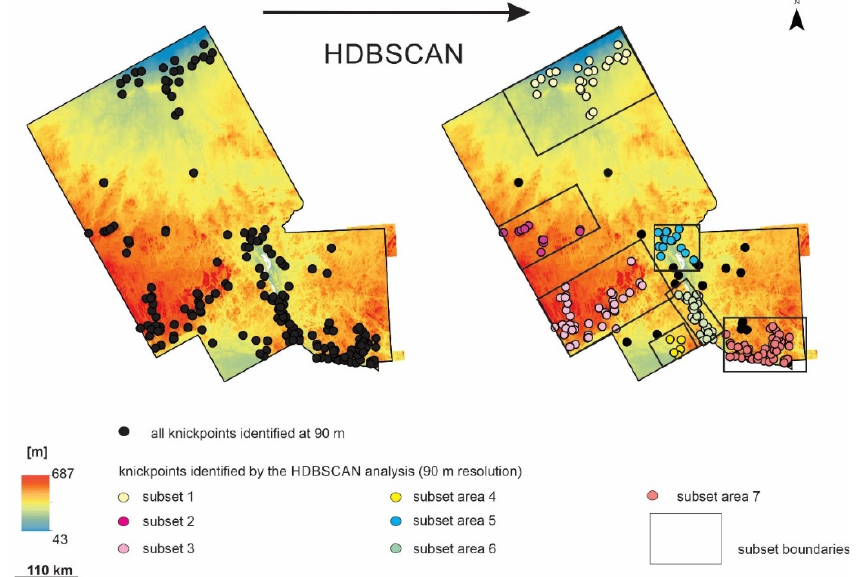
Figure 4. Combined DEM of our study area centered around the Temiskaming Graben with Knickpoints detected at 90 m resolution. The DEM was resampled at 90 m resolution in order to obtain the locations of the knickpoints across the whole study area. This resolution was found efficient for the hydrological calculations run in the MATLAB based software code TopoToolbox [99,100]. HDBSCAN cluster analysis [109] was then run for further detailing our analysis and divide the broad study area into subsets. Seven clusters of knickpoints were thus obtained by the previous passage, and each of these was used to identify a subset of the broad study area (right hand side of the figure). Within each of these subsets a new knickpoint analysis was run at 30 m resolution to confirm and/or improve the resolution of the siting of the knickpoints found at 90 m. Each identified cluster at 90 m first and then at 30 m of resolution was denoted by colored symbols, and it defines a subset of the study area. The same colors for each cluster/subset area were used for the upcoming maps. The subset areas identified by the knickpoint clusters are outlined by a black rectangular shape.